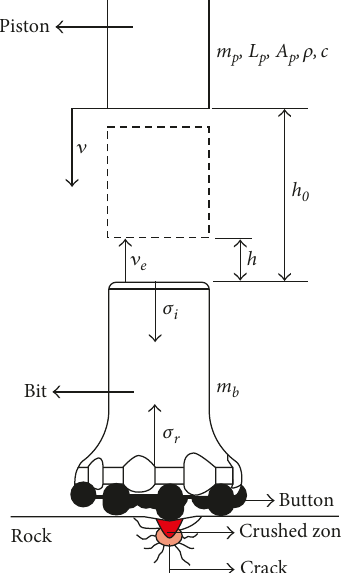
Figure 2: Schematic rock fracture mechanism by percussive drilling (modified from Cho et al.